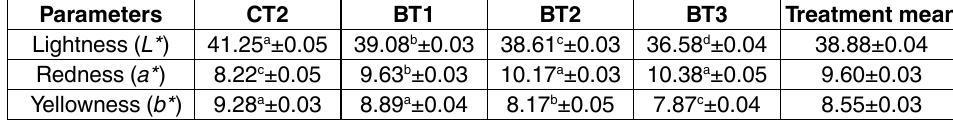
table 4. Effect of pearl millet flour on colour parameters (Mean±SE) of chicken sausage Parameters